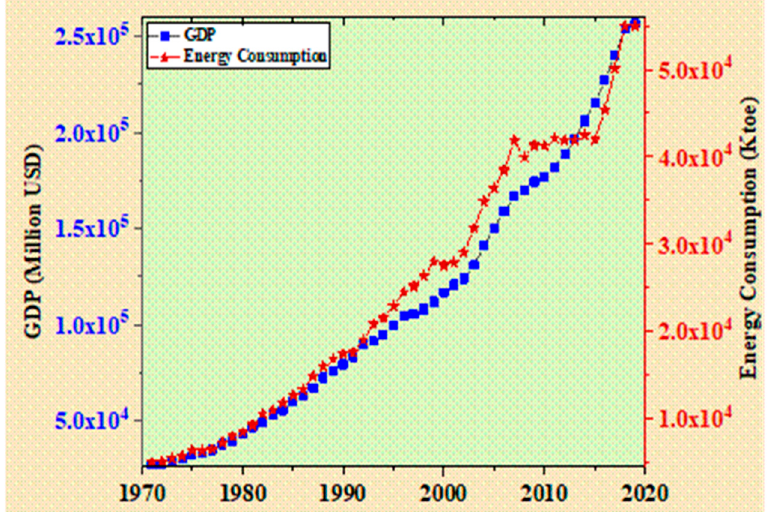
Figure 3 . Energy consumption versus GDP in Pakistan . Figure 3. Energy consumption versus GDP in